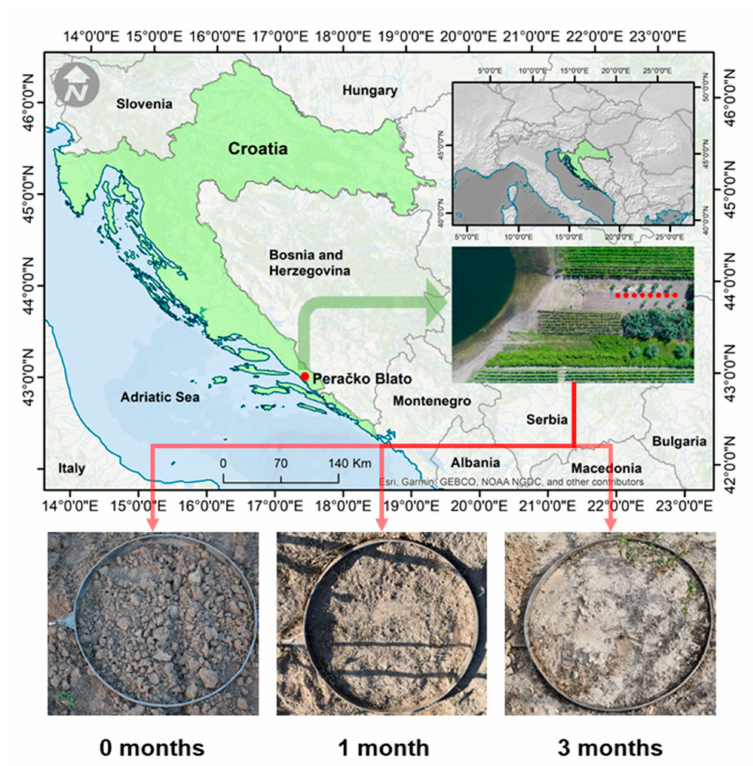
Figure 1. Location of the Peraˇcko Blato study area, the eight experimental plots, and temporal changes in the soil surface within the fig